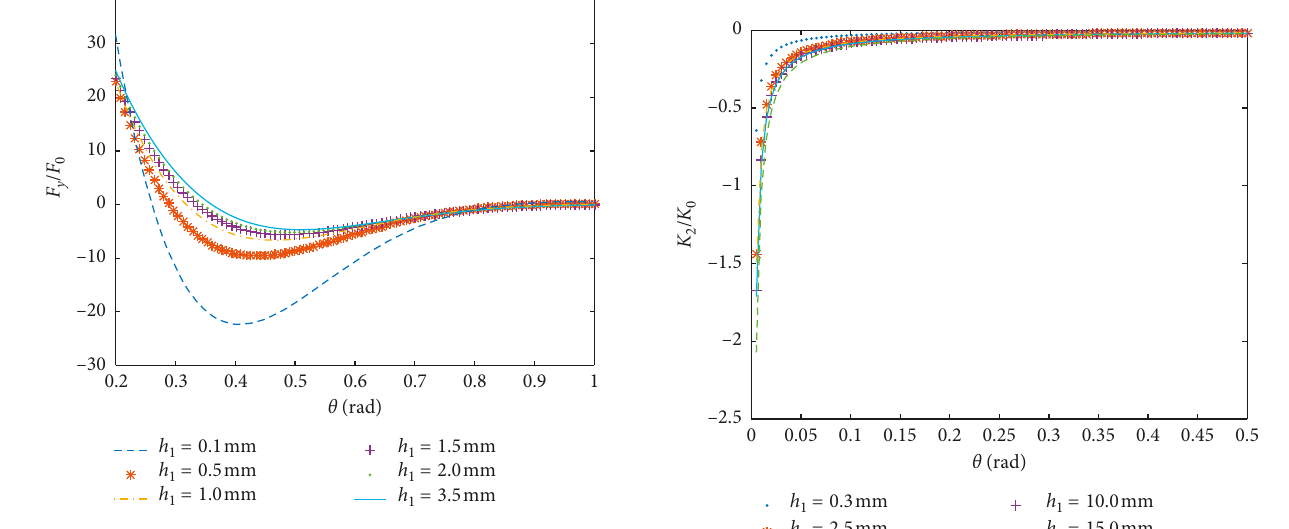
Figure 14: Relationship between image force F different values of parameter h